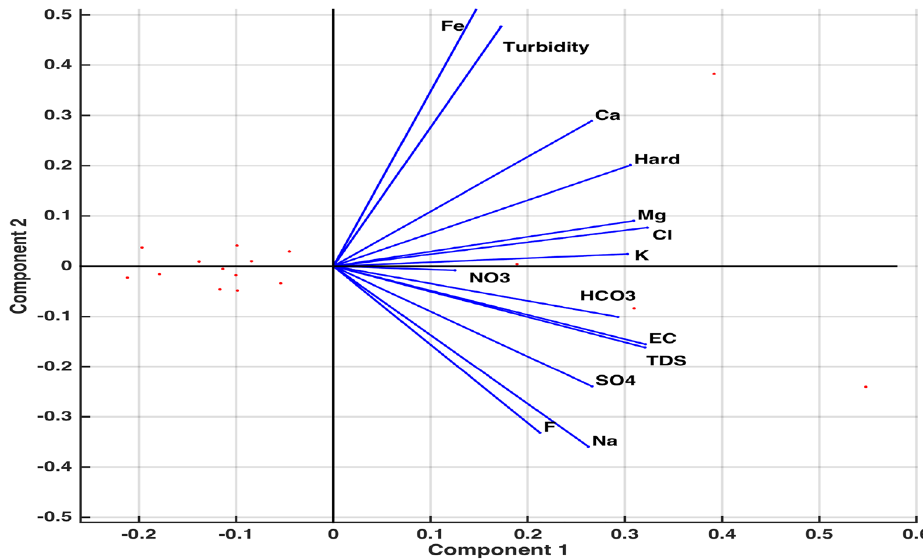
Figure 11. Principal component coefficients & principal component scores plot.